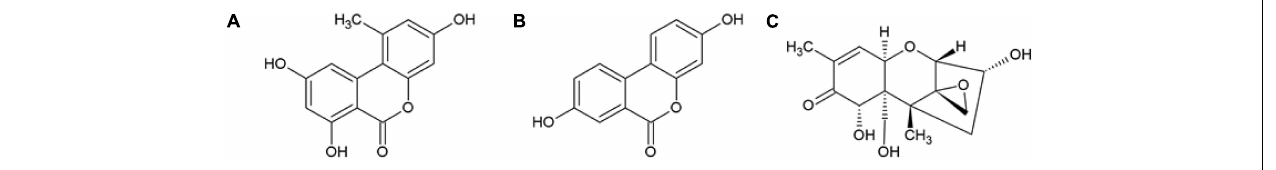
FIGURE 1 | Structures of (A) the ellagic acid gut microbiota metabolite, urolithin A (Uro A), (B) the Alternaria alternata secondary metabolite alternariol (AOH), and (C) the Fusarium spp. fungal metabolite deoxynivalenol